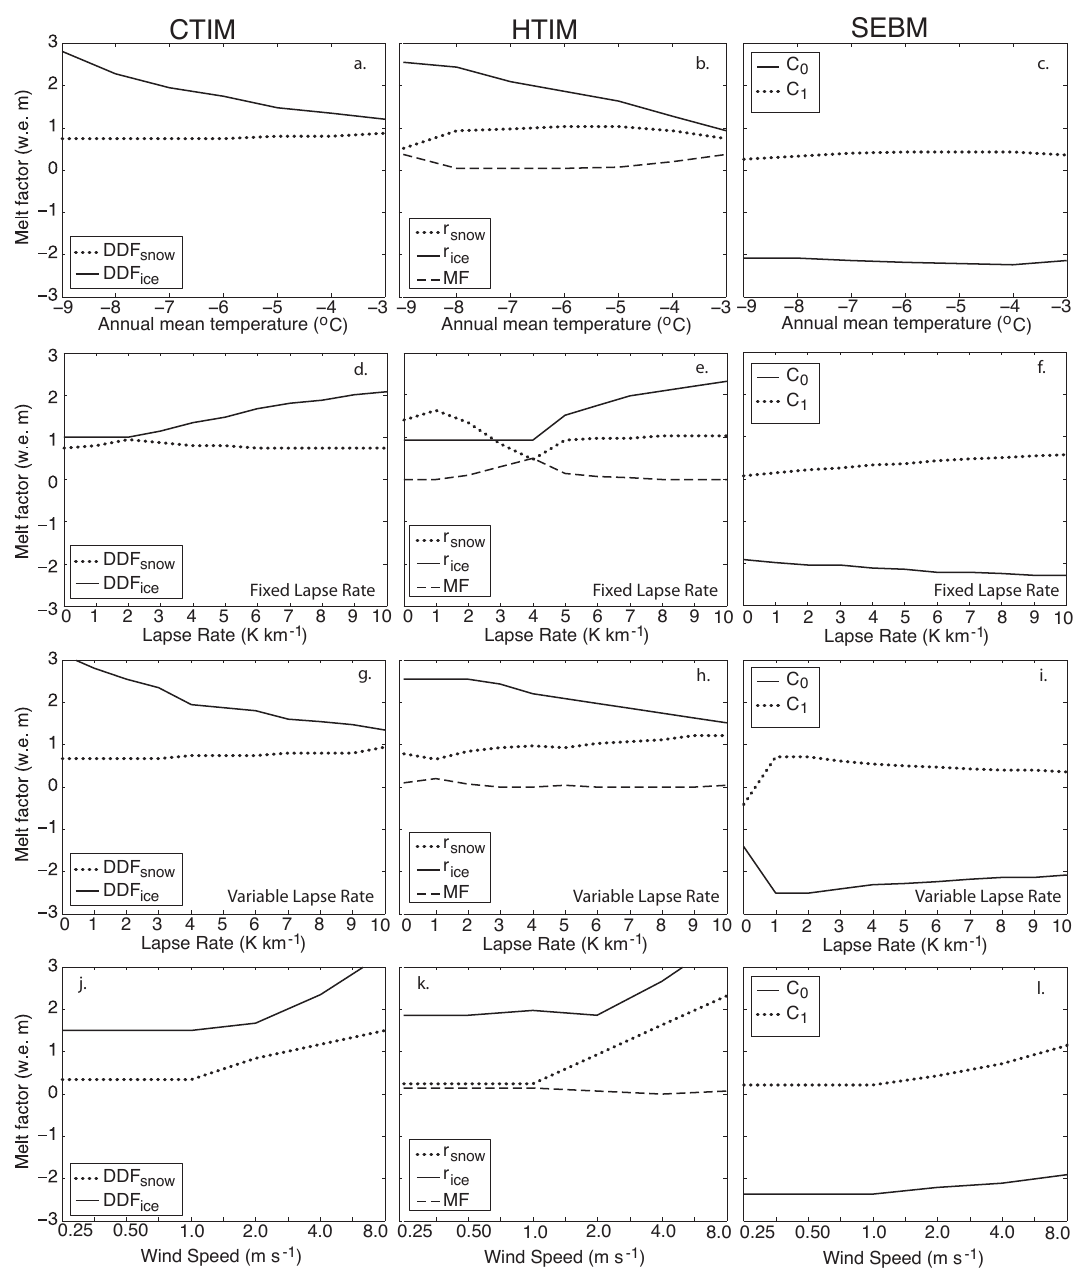
Fig. 6. Melt-model parameter sensitivity to mean annual air temperature (first row), temperature lapse rate (second and third rows) and wind speed (fourth row). Melt models use a constant lapse rate of − 6.5 ◦ Ckm − 1 in the “fixed” lapse-rate test (second row) and are fed the lapse rate used in the IEBM in the “variable” test (third row). Note the logarithmic scale for wind